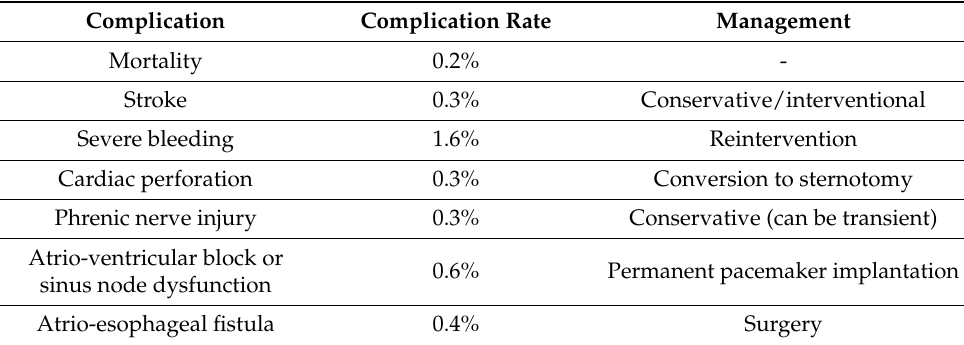
Table 2. Summary of complications and management